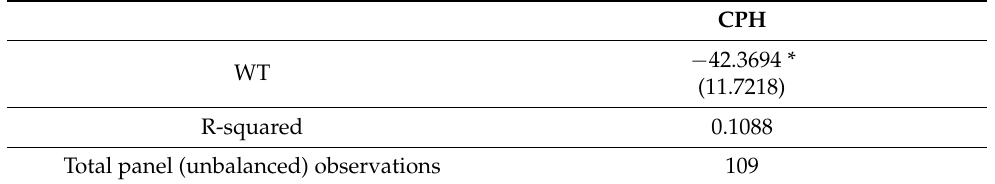
Table 7. Empirical results on the customers per hour (CPH)